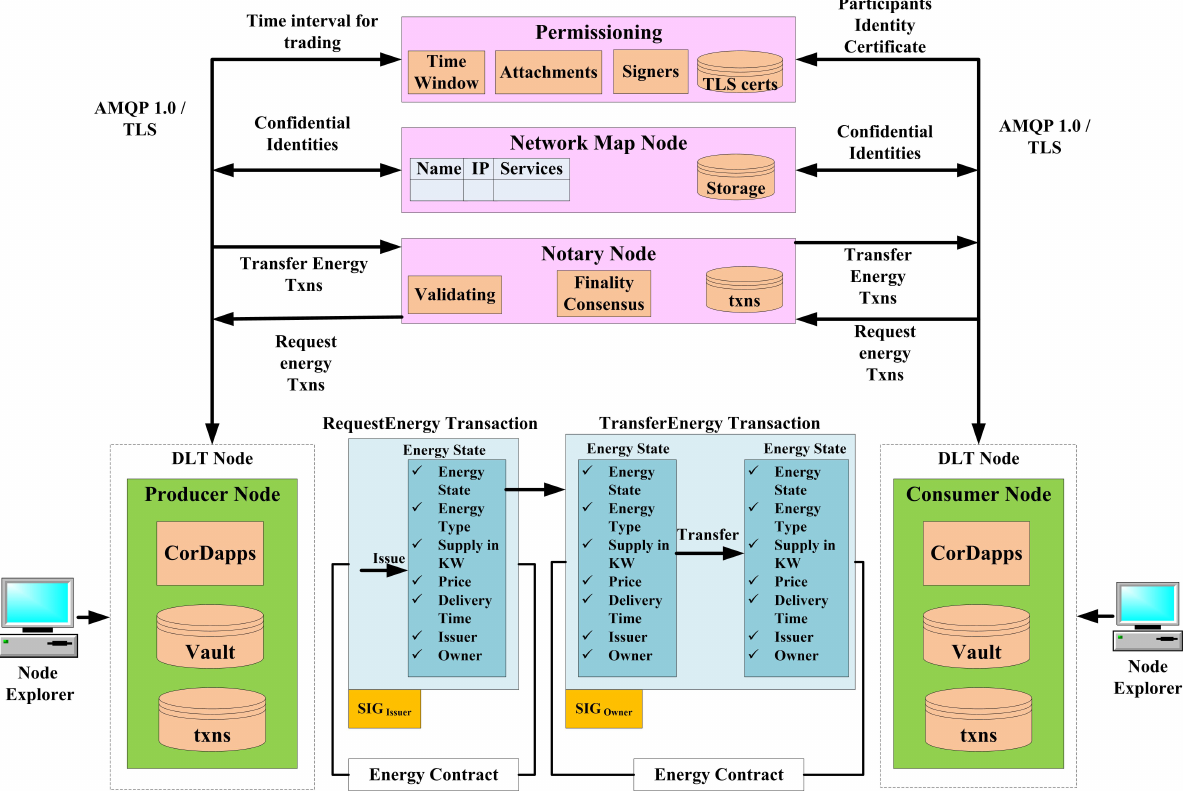
Figure 2. Proposed framework for P2P energy